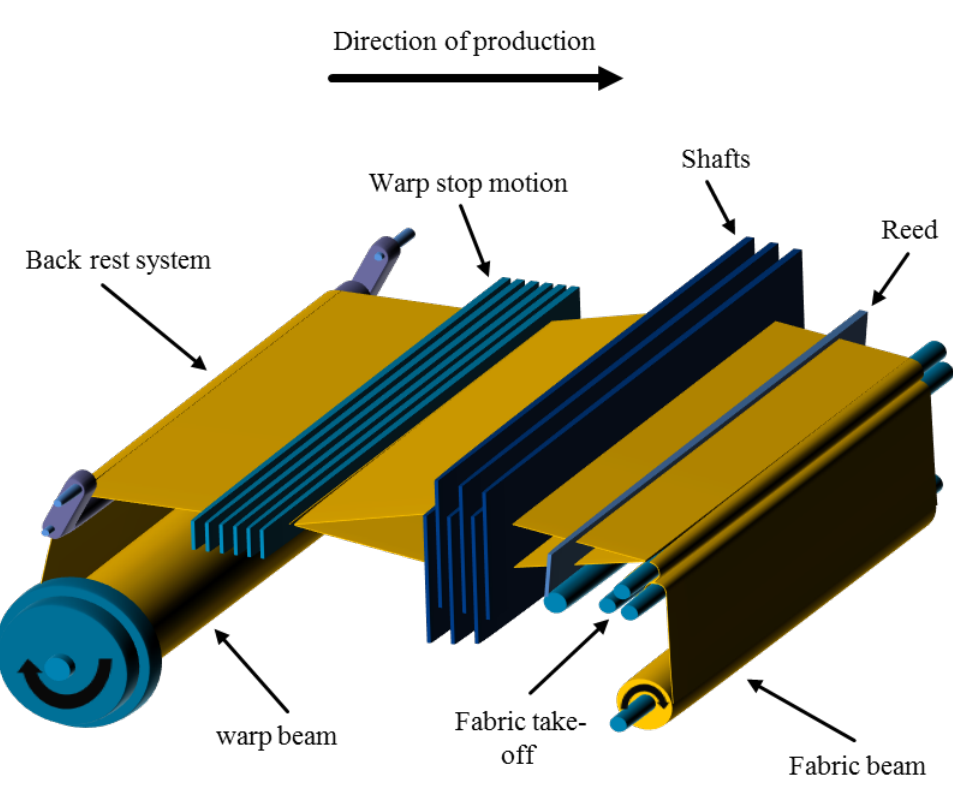
Figure 1. Principle of a weaving machine